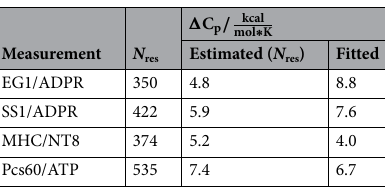
Table 1. Estimated and fitted ∆C p values for the systems presented in this work. The ∆C p was estimated using Eq. (15).